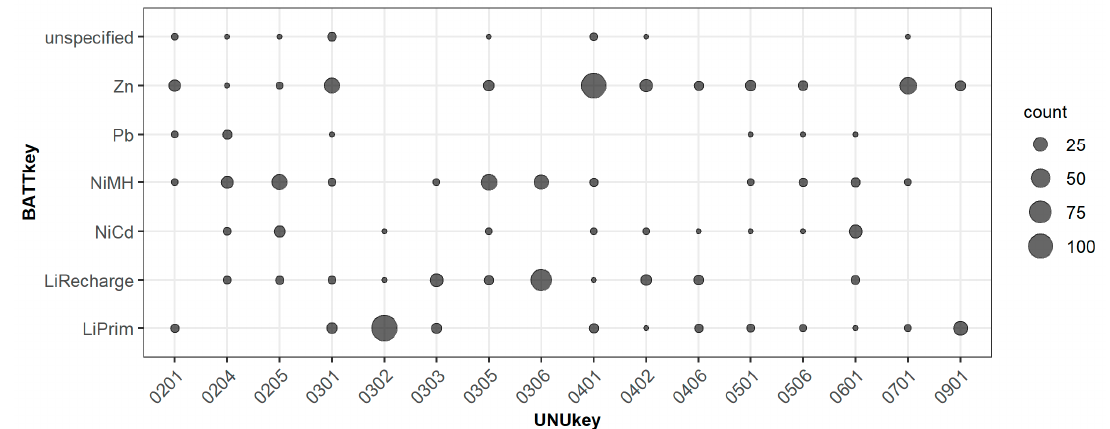
Figure 4. Occurrence and count of battery types (BATTkeys) in UNUkeys. Total number of devices considered: 790. Figure data are given in the Supplementary Materials Table S7.